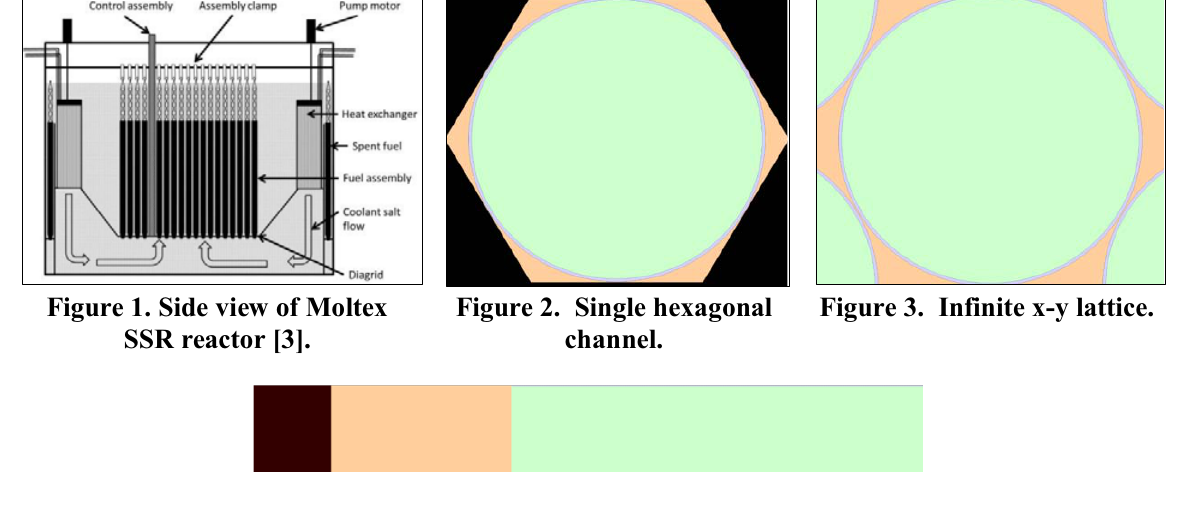
Figure 1. Side view of Moltex SSR reactor [3].